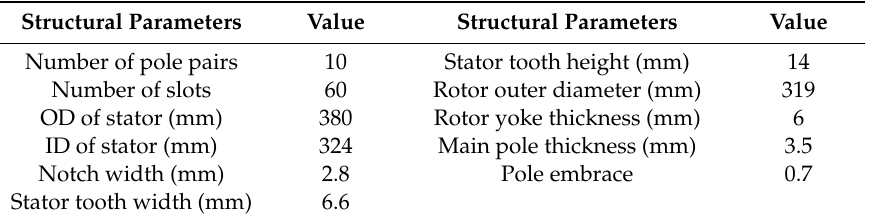
Table 1. Main structural parameters of the